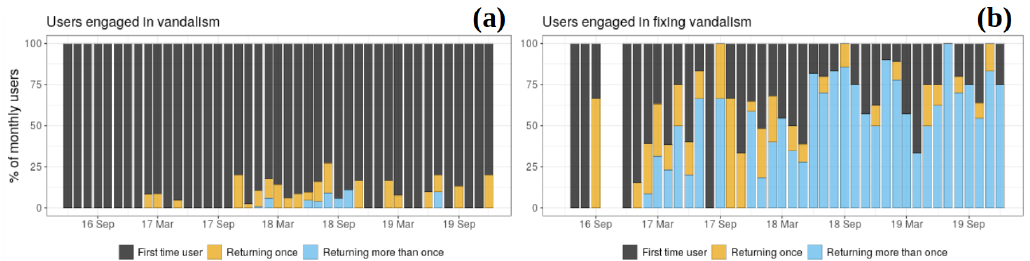
Figure 12. Shares of different user types for ( a ) PGO vandalism events and ( b ) for